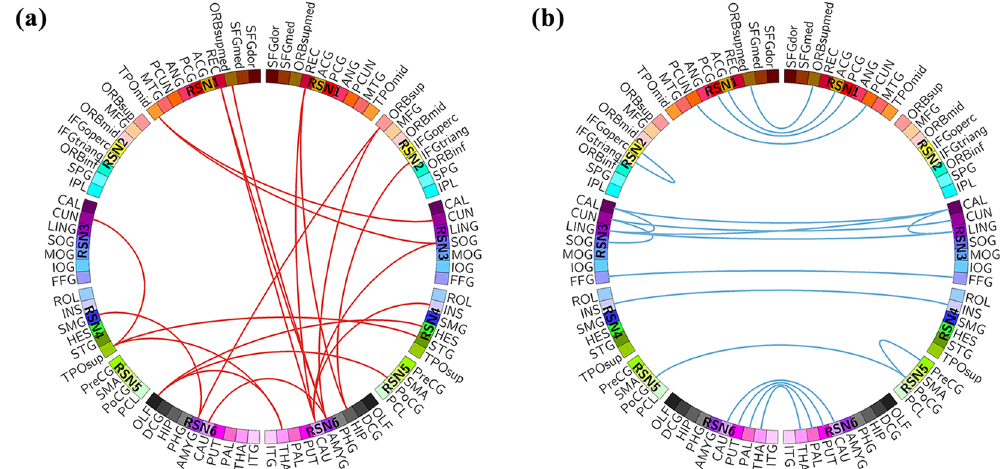
Figure 2. Connectogram of functional connections with the largest and the lowest 0.5% SampEn. Functional connections with the largest SampEn ( a ). Functional connections with the lowest SampEn ( b ). The left part and the right part of the connectogram represent the left hemisphere and the right hemisphere of the brain, respectively. Supplementary Table S1 lists the full name of each